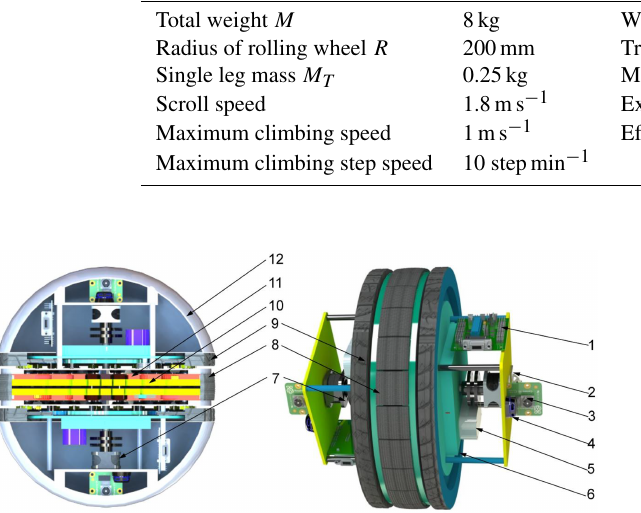
Figure 2. Overall structure of wheel–leg deformation